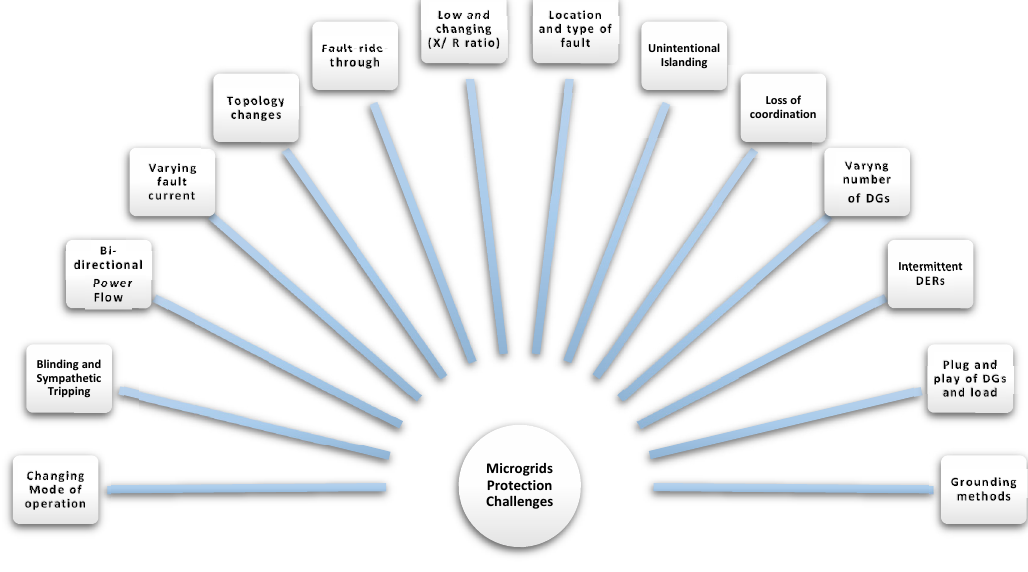
Figure 2. Protection challenges of the MGs system.